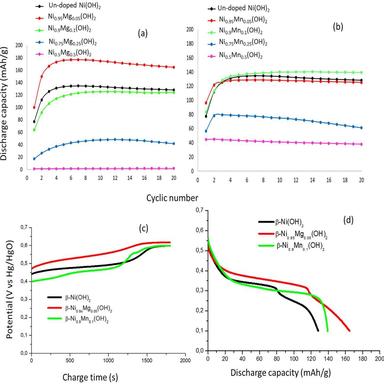
CCDG discharge capacities curves of (a) Ni1-xMgx(OH)2 compositions, (b) Ni1-xMnx(OH)2 compositions, and the (c) charge curve (d) discharge curve at the 20th cycle of the un-doped Ni(OH)2, Ni0.95Mg0.05(OH)2 and Ni0.9Mn0.1(OH)2.